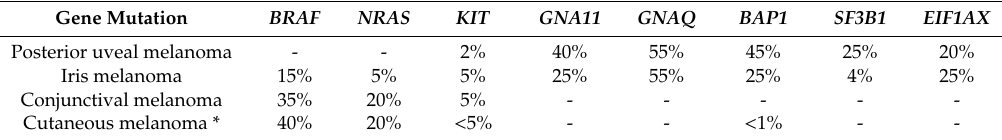
Table 1. Driver mutations in subtypes of primary